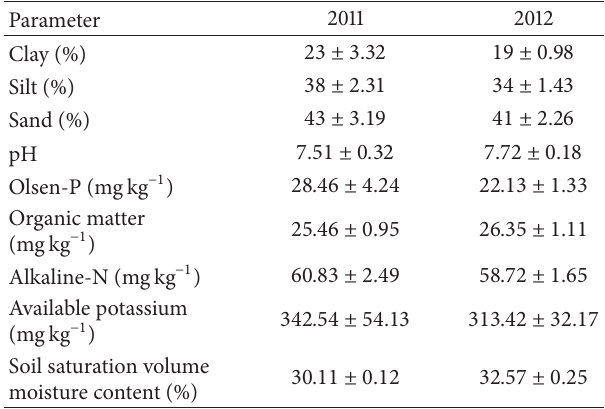
Table 1: Soil characteristics of the field experiments conducted in Shihezi in 2011 and 2012. Values are the mean ± standard error (SE); the SE was calculated across five replicates in both years and averaged for the nonflooded irrigation and conventional flooding